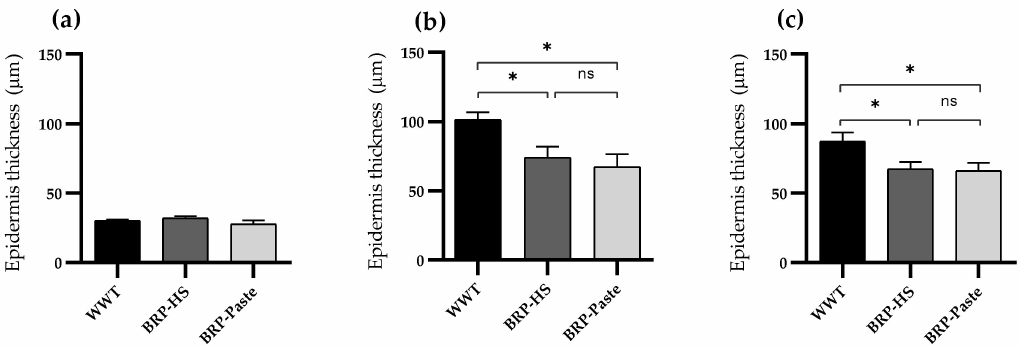
Figure 5. Epidermis’ thickness ( µ m) of groups WWT, HS, BRP-HS, Paste and BRP-Paste in 3 ( a ), 7 ( b ) and 14 days ( c ) of treatment, analyzed in HE stained skin samples. Results expressed according to one-way ANOVA followed by Newman-Keuls test, * p < 0.05 ( n = 6). ns = no